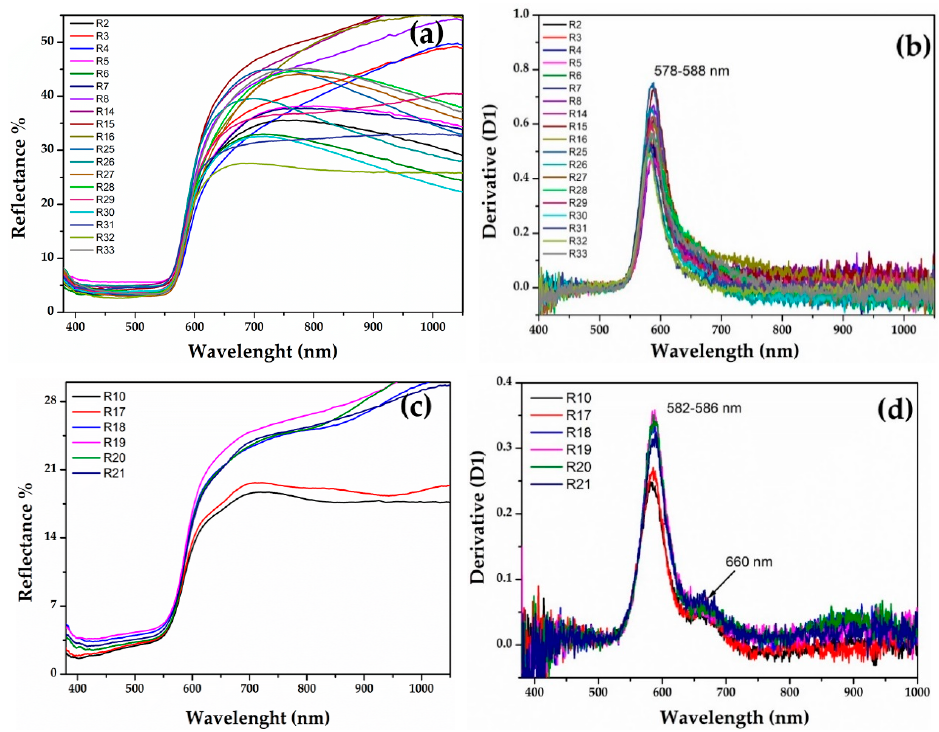
Figure 6. ( a ) Reflectance spectra of Gr-1 samples and the calculated first derivative ( b ); reflectance spectra of Gr-2 samples ( c ) and their first derivative ( d ).